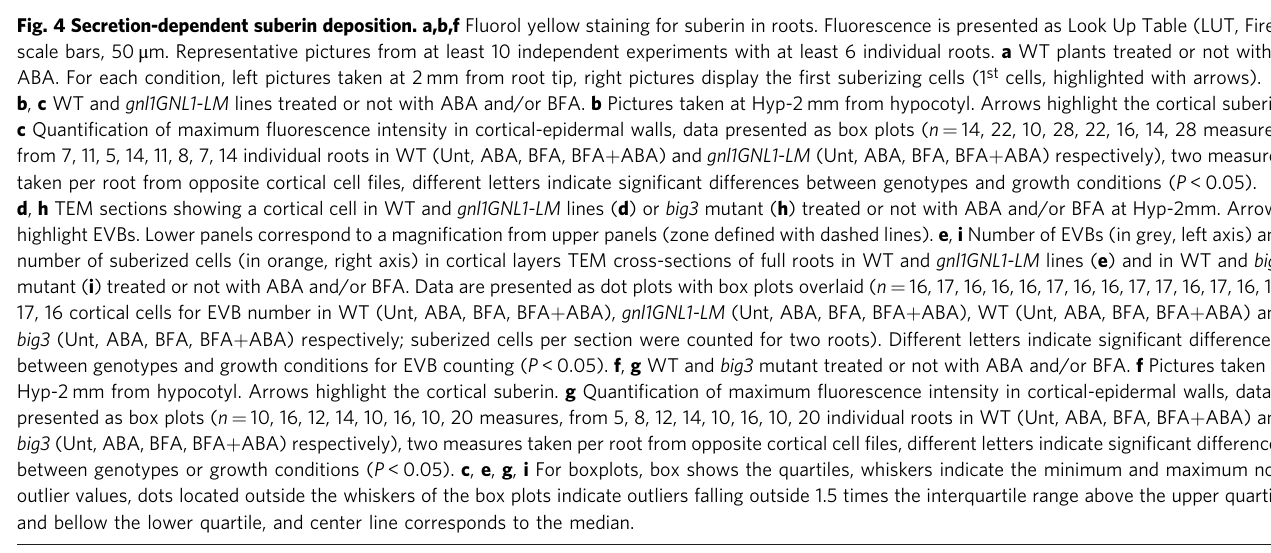
Fig. 4 Secretion-dependent suberin deposition. a,b,f Fluorol yellow staining for suberin in roots. Fluorescence is presented as Look Up Table (LUT, Fire), scale bars, 50 μ m. Representative pictures from at least 10 independent experiments with at least 6 individual roots. a WT plants treated or not with ABA. For each condition, left pictures taken at 2 mm from root tip, right pictures display the fi rst suberizing cells (1 st cells, highlighted with arrows). b , c WT and gnl1GNL1-LM lines treated or not with ABA and/or BFA. b Pictures taken at Hyp-2 mm from hypocotyl. Arrows highlight the cortical suberin. c Quanti fi cation of maximum fl uorescence intensity in cortical-epidermal walls, data presented as box plots ( n = 14, 22, 10, 28, 22, 16, 14, 28 measures, from 7, 11, 5, 14, 11, 8, 7, 14 individual roots in WT (Unt, ABA, BFA, BFA + ABA) and gnl1GNL1-LM (Unt, ABA, BFA, BFA + ABA) respectively), two measures taken per root from opposite cortical cell fi les, different letters indicate signi fi cant differences between genotypes and growth conditions ( P < 0.05). d , h TEM sections showing a cortical cell in WT and gnl1GNL1-LM lines ( d ) or big3 mutant ( h ) treated or not with ABA and/or BFA at Hyp-2mm. Arrows highlight EVBs. Lower panels correspond to a magni fi cation from upper panels (zone de fi ned with dashed lines). e , i Number of EVBs (in grey, left axis) and number of suberized cells (in orange, right axis) in cortical layers TEM cross-sections of full roots in WT and gnl1GNL1-LM lines ( e ) and in WT and big3 mutant ( i ) treated or not with ABA and/or BFA. Data are presented as dot plots with box plots overlaid ( n = 16, 17, 16, 16, 16, 17, 16, 16, 17, 17, 16, 17, 16, 16, 17, 16 cortical cells for EVB number in WT (Unt, ABA, BFA, BFA + ABA), gnl1GNL1-LM (Unt, ABA, BFA, BFA + ABA), WT (Unt, ABA, BFA, BFA + ABA) and big3 (Unt, ABA, BFA, BFA + ABA) respectively; suberized cells per section were counted for two roots). Different letters indicate signi fi cant differences between genotypes and growth conditions for EVB counting ( P < 0.05). f , g WT and big3 mutant treated or not with ABA and/or BFA. f Pictures taken at Hyp-2 mm from hypocotyl. Arrows highlight the cortical suberin. g Quanti fi cation of maximum fl uorescence intensity in cortical-epidermal walls, data presented as box plots ( n = 10, 16, 12, 14, 10, 16, 10, 20 measures, from 5, 8, 12, 14, 10, 16, 10, 20 individual roots in WT (Unt, ABA, BFA, BFA + ABA) and big3 (Unt, ABA, BFA, BFA + ABA) respectively), two measures taken per root from opposite cortical cell fi les, different letters indicate signi fi cant differences between genotypes or growth conditions ( P < 0.05). c , e , g , i For boxplots, box shows the quartiles, whiskers indicate the minimum and maximum non outlier values, dots located outside the whiskers of the box plots indicate outliers falling outside 1.5 times the interquartile range above the upper quartile and bellow the lower quartile, and center line corresponds to